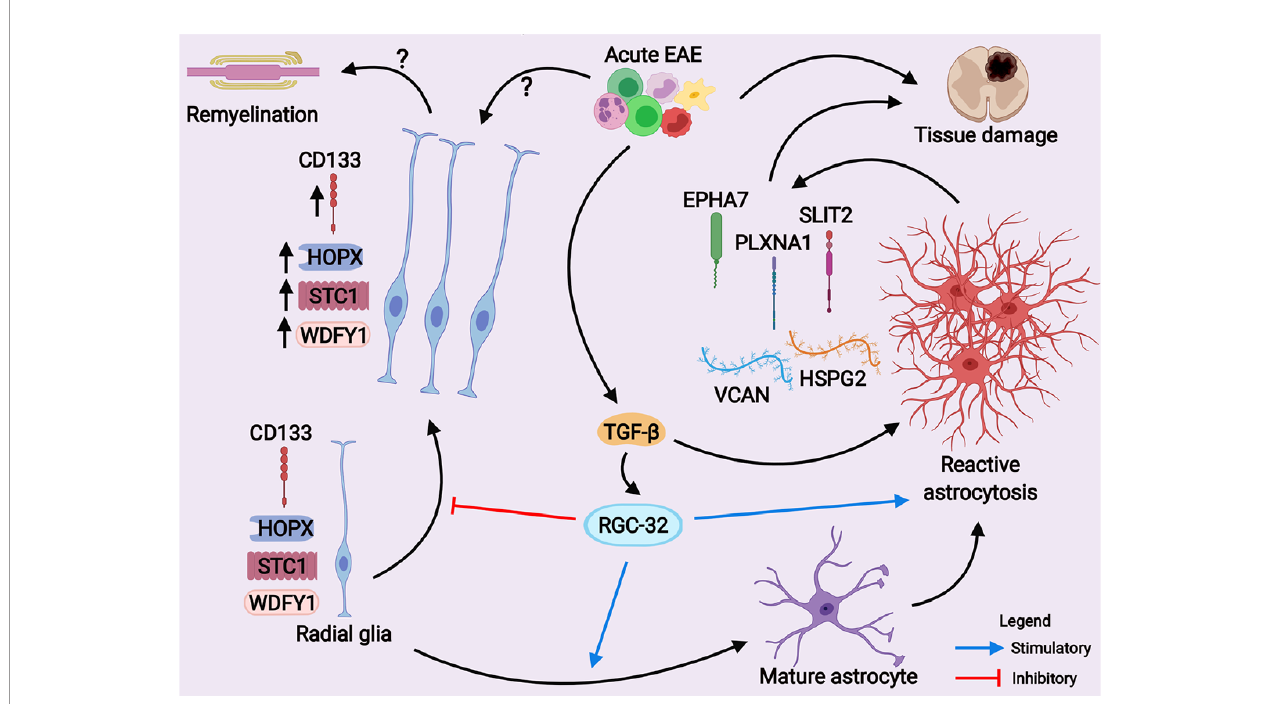
FIGURE 12 | A scheme depicting the main hypothesis of how RGC-32 works as a regulator of astrocyte development and reactive astrocytosis during EAE. Our current results suggest that RGC-32 facilitates a pathogenic reactive phenotype of astrocytes during acute EAE. On the other hand, RGC-32 seems to negatively regulate the proliferation, morphological changes and possibly migration of CD133 + , HOPX + , STC1 + and WDFY1 + radial glia at the peak of EAE, as these cells increase their number and become more elongated when RGC-32 is absent. However, whether these radial glia cells exert protective effects is yet to be established. (Created with